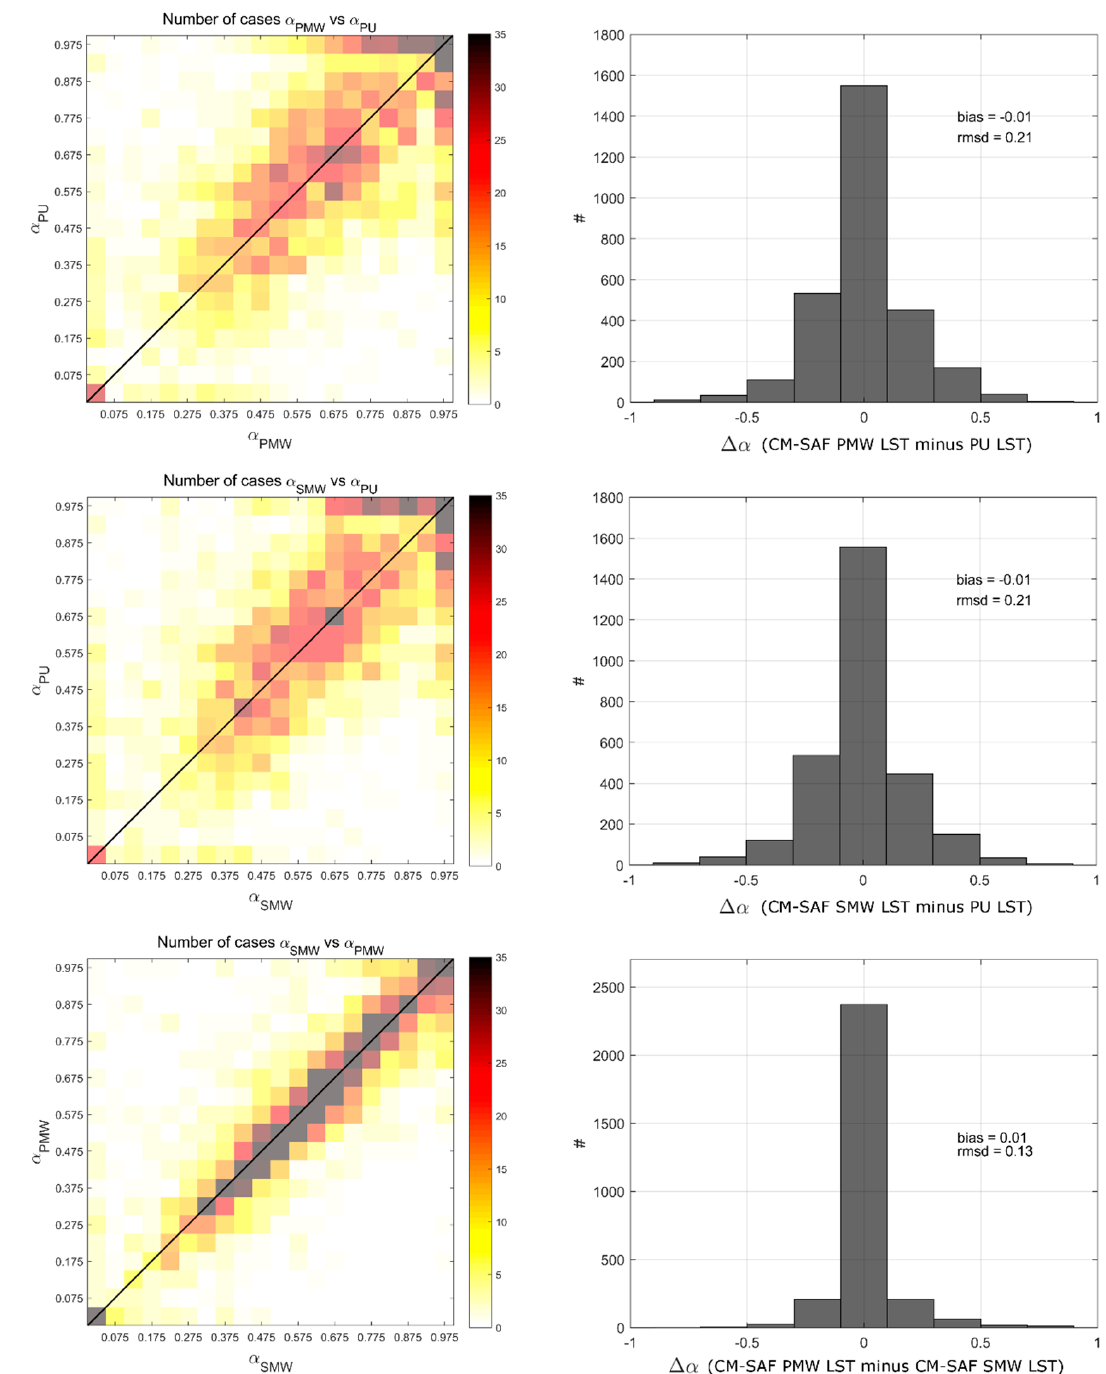
Figure 2. Scatter plots ( left ) and histograms of differences ( right ) resulting from the comparison of parameter α estimated with TCI derived with CM-SAF PMW LST versus PU LST ( top ), CM-SAF SMW LST versus PU LST ( middle ), and the two CM-SAF LSTs ( bottom ). Bias and root mean squared deviations (RMSD) are shown on the histograms.